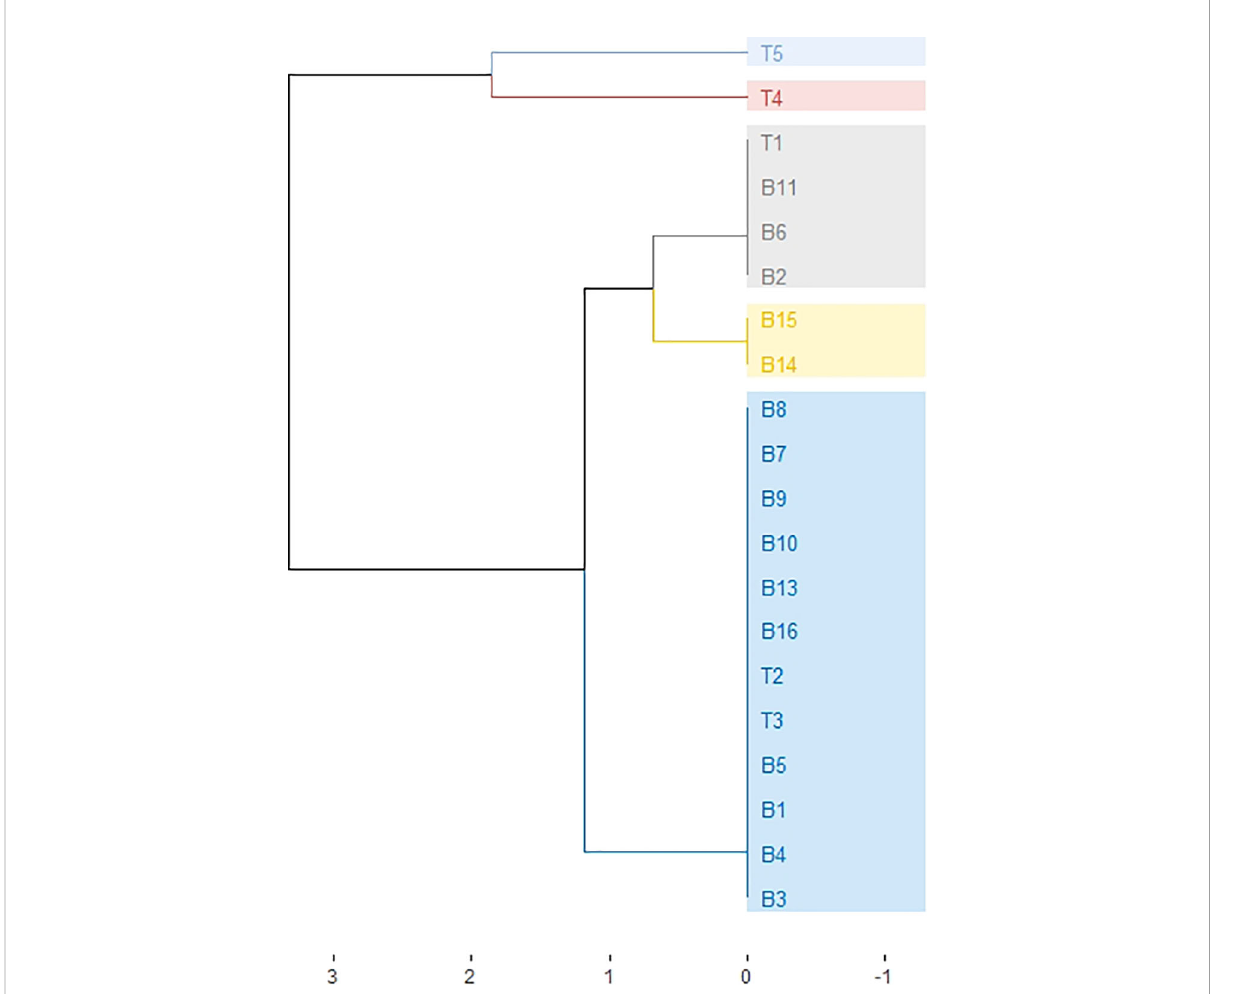
FIGURE 2 Dissimilarity dendrogram showing the genetic relationships among the Belltall (B) and control (T) garlics. The dendrogram was generated by Hierarchical Cluster on Principal Components (HCPC) analysis based on the eight SSR markers. Accessions with the same genotype are grouped by